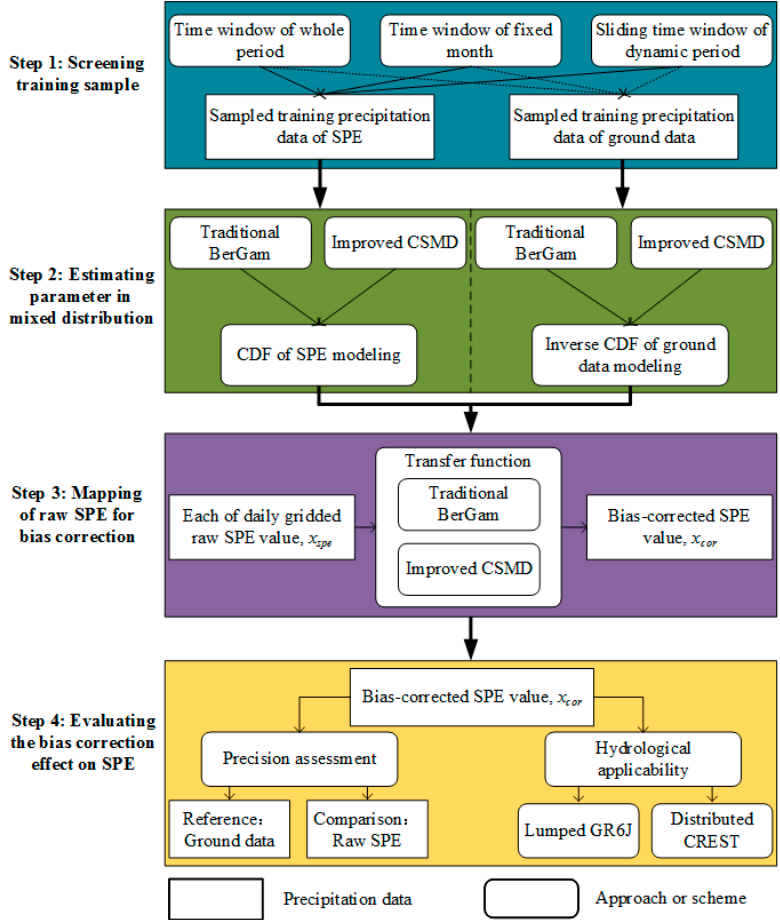
Figure 3. Flowchart of the bias correction process used in the